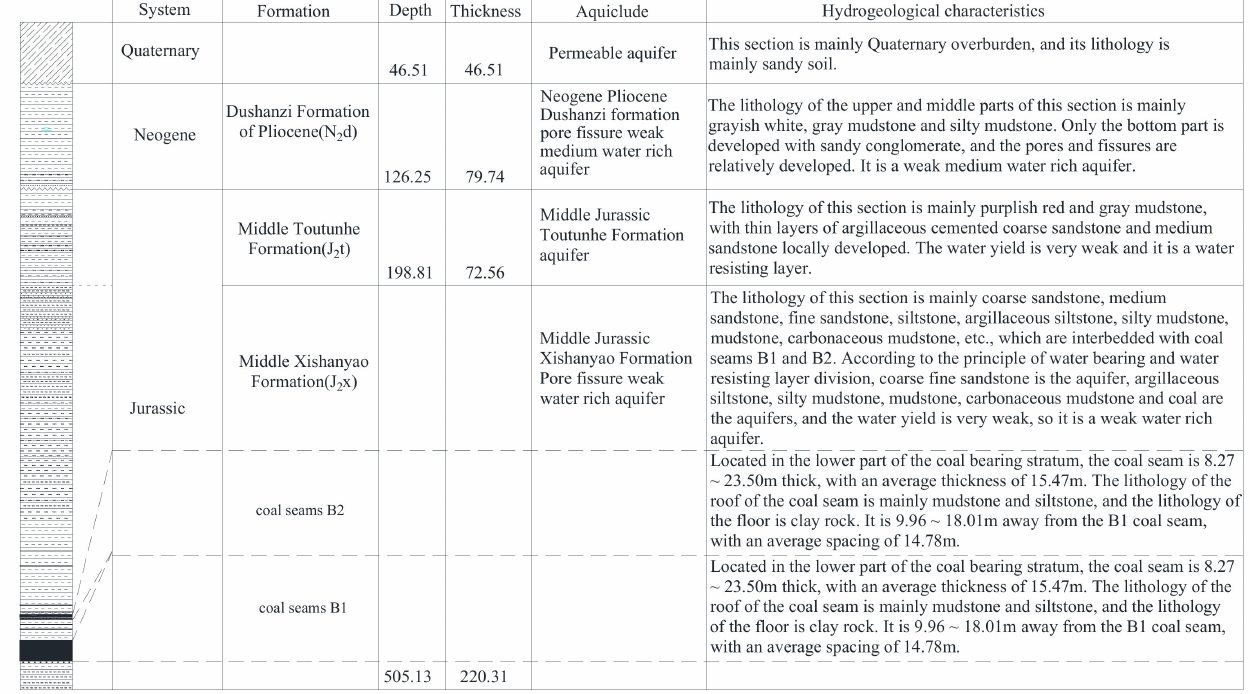
Figure 2. The lithology of the site under